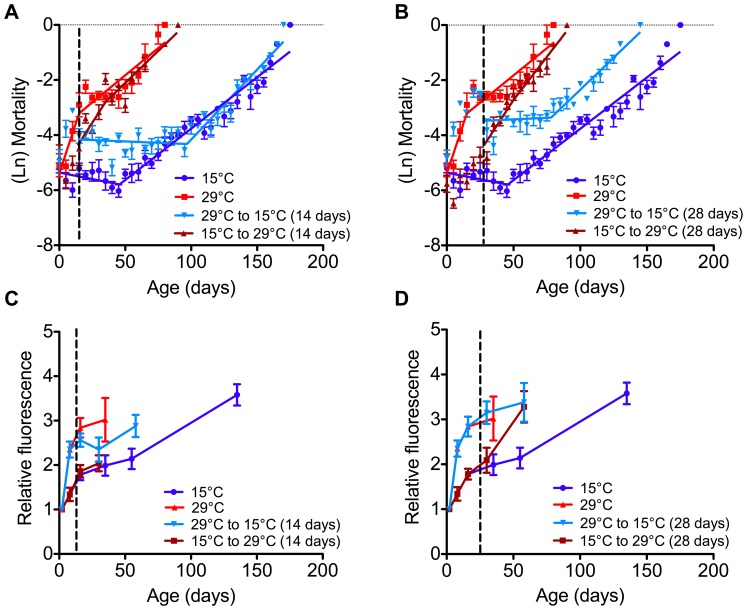
Cellular and demographic senescence of adult Calliphora stygia transferred between high (29°C) and low (15°C) temperatures.(A) Age-specific mortality of flies that were transferred between temperatures after 14 days. Data are presented with data points calculated as an average of a five-day period (error bars are omitted for clarity). See Table 2 for analyses of slopes. (B) Age-specific mortality of flies that were transferred between temperatures after 28 days. Data are presented with data points calculated as an average of a five-day period (error bars are omitted for clarity). See Table 2 for analyses of slopes. (C) Fluorescent AGE pigment accumulation in whole body samples of flies transferred between temperatures after 14 days (represented by the vertical dotted line). Data points are means ± one SEM (N = 6). (D) Fluorescent AGE pigment accumulation in whole body samples of flies transferred between temperatures after 28 days (represented by the vertical dotted line). Data points are means ± one SEM (N = 6).